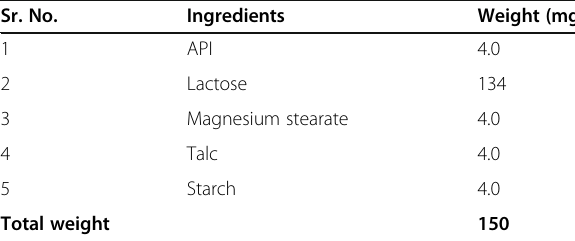
Table 3 The formula for one tablet Sr.